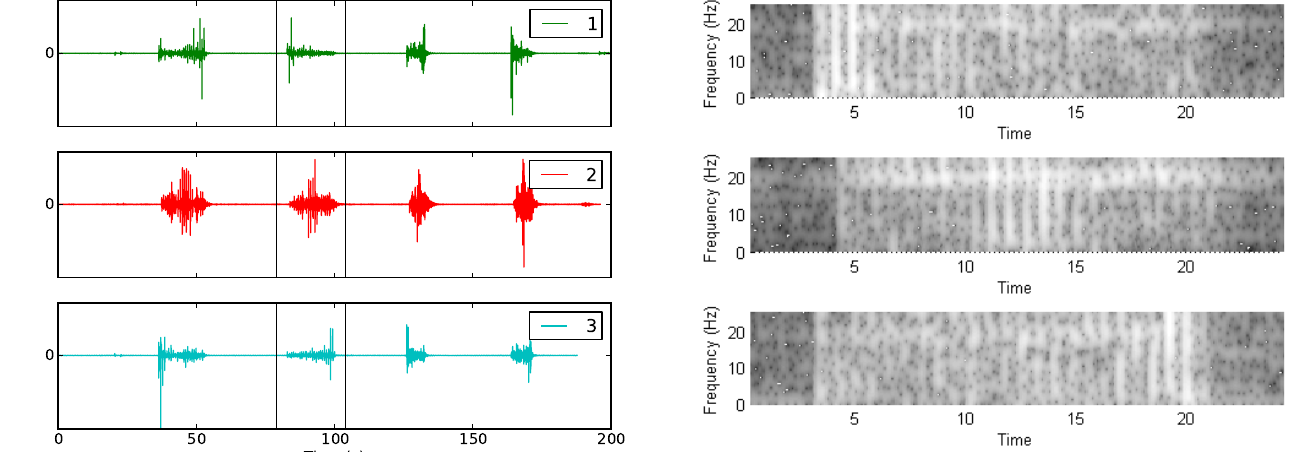
Fig. 20: Signal intensity of 4 bridge crossings Ricardo Lopes Pereira et al : A Wireless Sensor Network for Monitoring Volcano-seismic signals Figure 20. Signal intensity of four bridge crossings. Fig. 18: Evolution of external battery charge using 30W solar panel on a sunny day